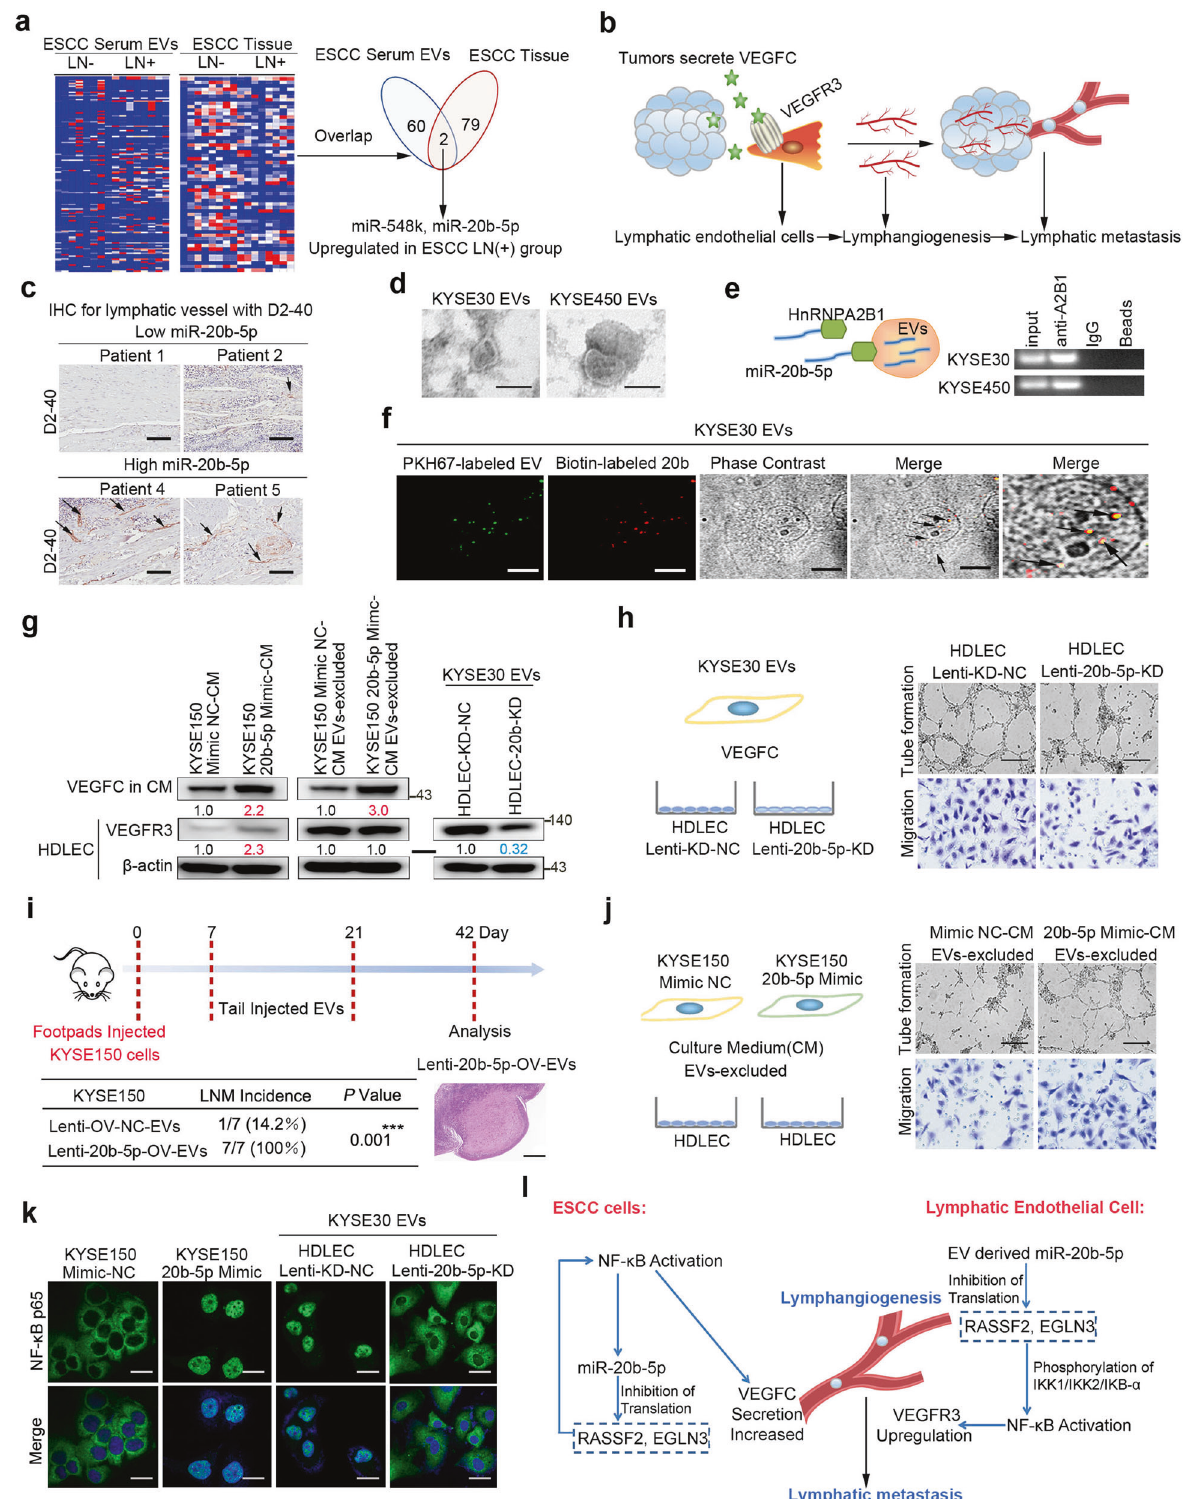
with EVs (Supplementary Fig. 9a, b and Supplementary Tables S3, 4). The p65 transcription factor in the NF- κ B signaling pathway has been reported to transactivate the expression of VEGFC and VEGFR3. We identi fi ed RASSF2 and EGLN3, which were involved in the NF- κ B/p65 signaling pathway, 4,5 as target genes of miR-20b-5p